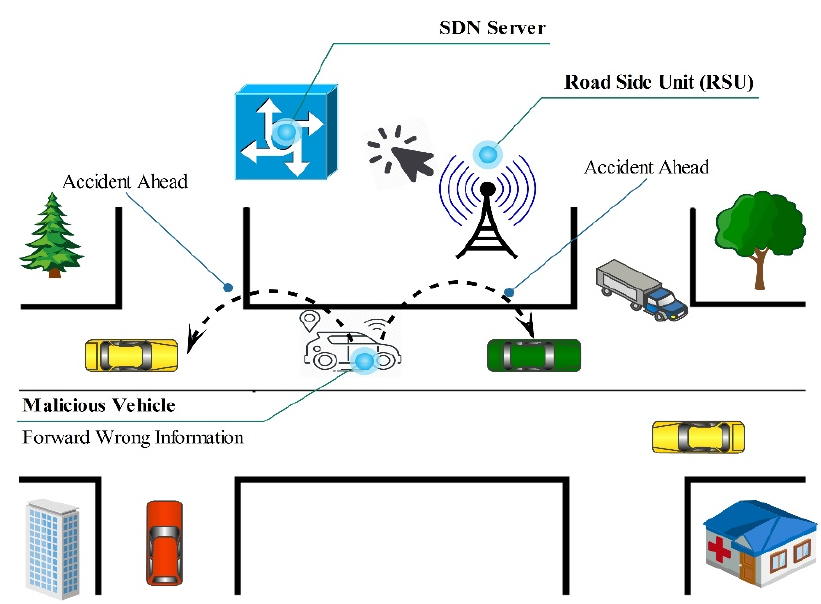
Figure 12. Denial of Service (DoS) attack in SDN-based VANETs.